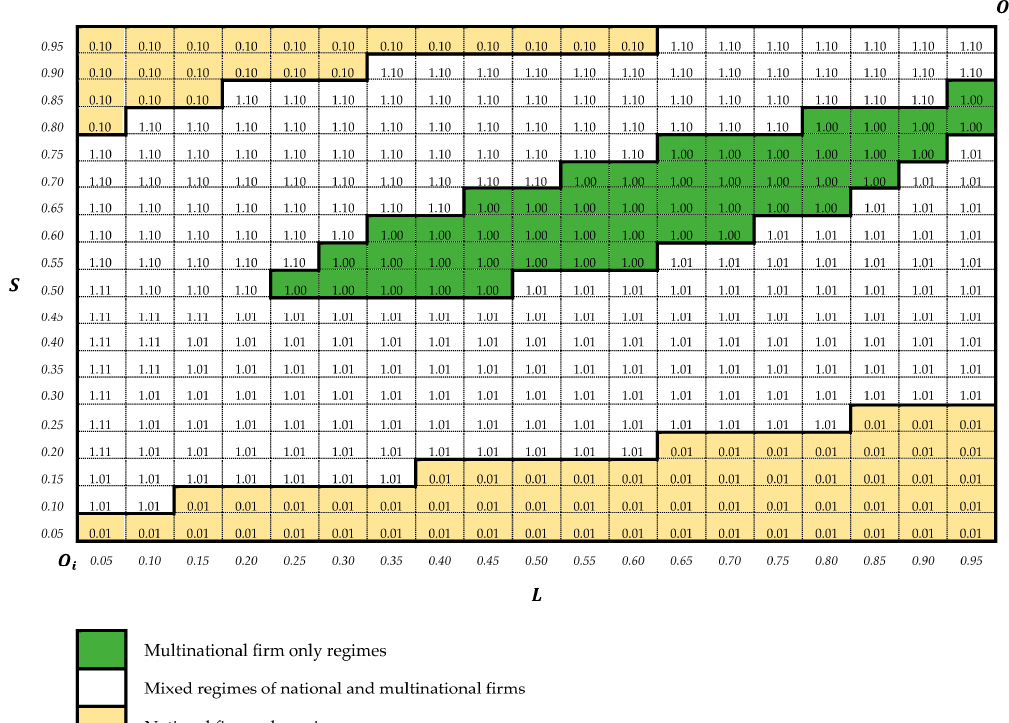
Figure 2. Equilibrium regimes ( v i = 0.2).